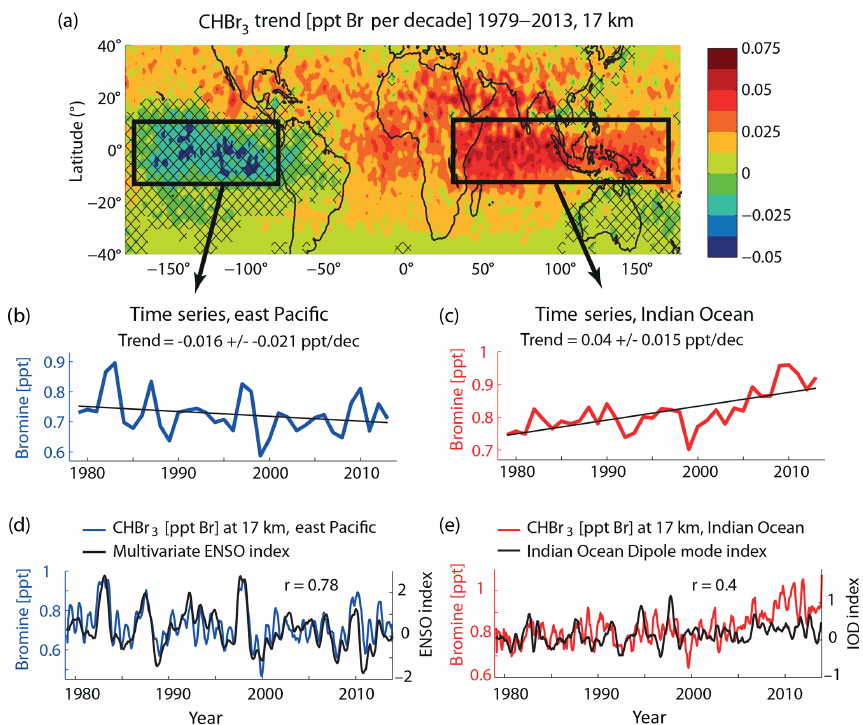
Figure 9. Modelled long-term change of CHBr 3 (Br per decade) at 17km for the time period 1979–2013 (a) . Time series (annual means) averaged over the east Pacific and the Indian Ocean–Maritime Continent–west Pacific region are shown together with the trend (b, c) . Time series (5-month running mean) are shown together with the ENSO index and Indian Ocean Dipole index (d, e) .